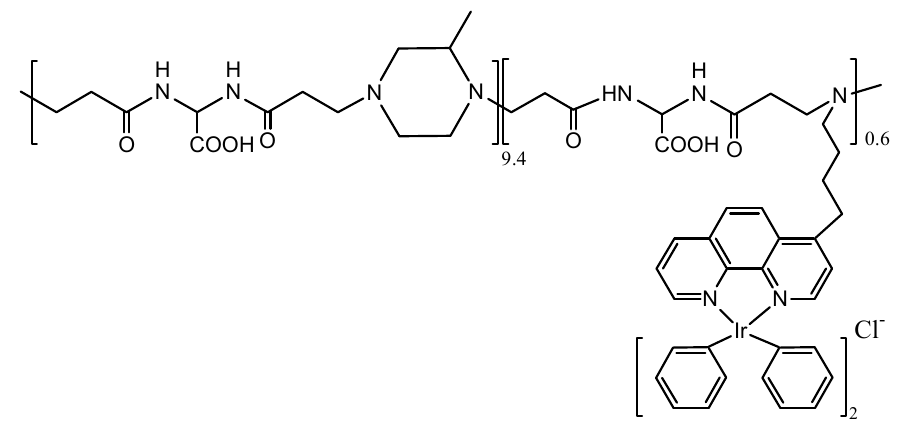
Figure 24. Poly(amidoamine) Ir(III) complex as a new 1 O 2 sensitizer.